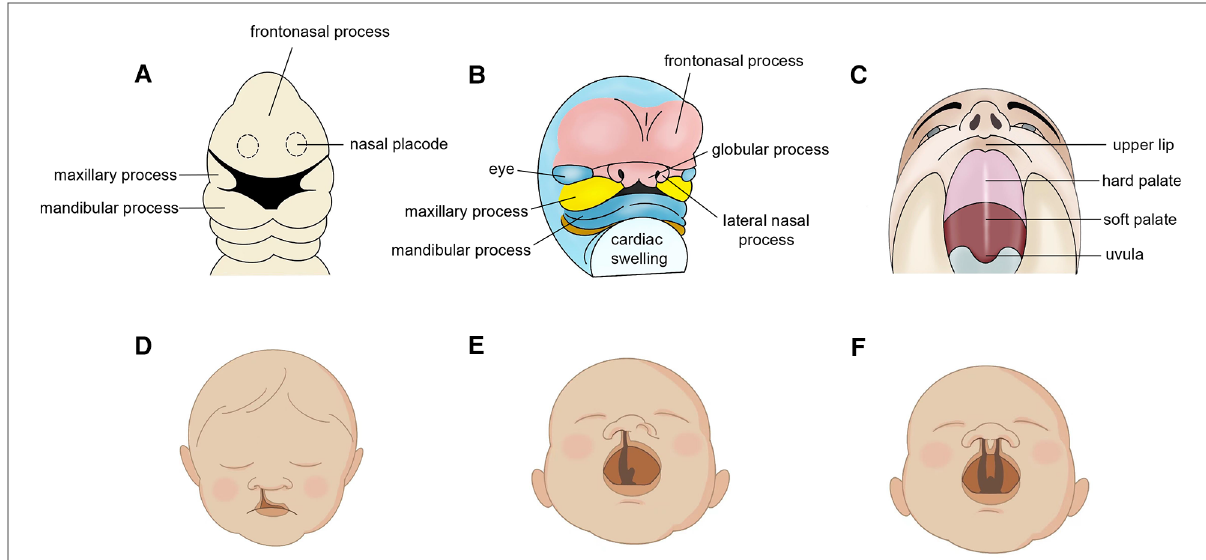
FIGURE 1 Embryonic development in oral and maxillofacial region. ( A ) embryonic week 4. ( B ) embryonic week 6. ( C ) developed lip and palate. Cleft phenotypes ( D ) Normal cleft lip. ( E ) unilateral cleft lip and palate (UCLP) and ( F ) bilateral cleft lip and palate